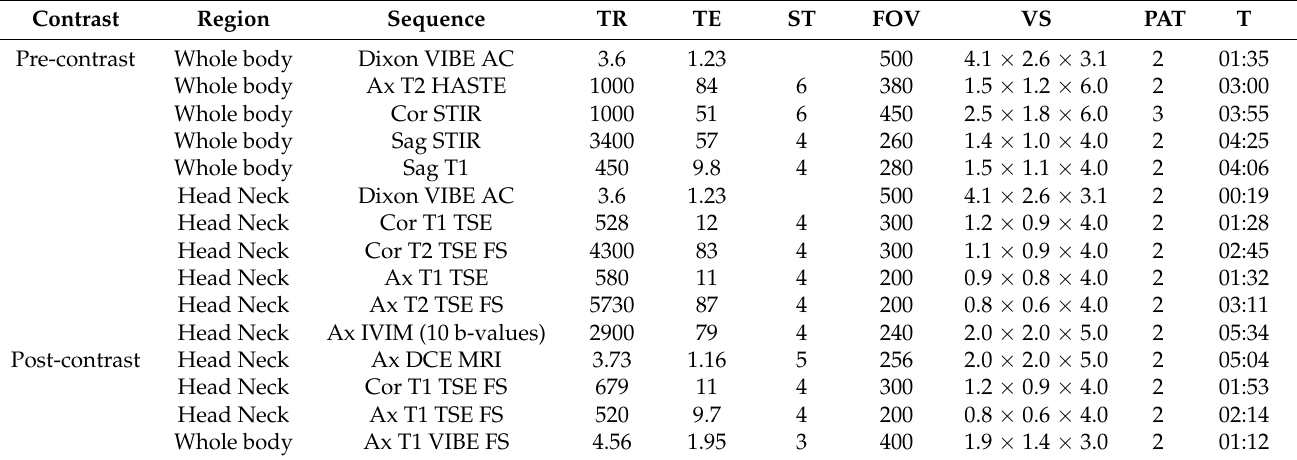
Table 1. MRI sequence parameters used for integrated